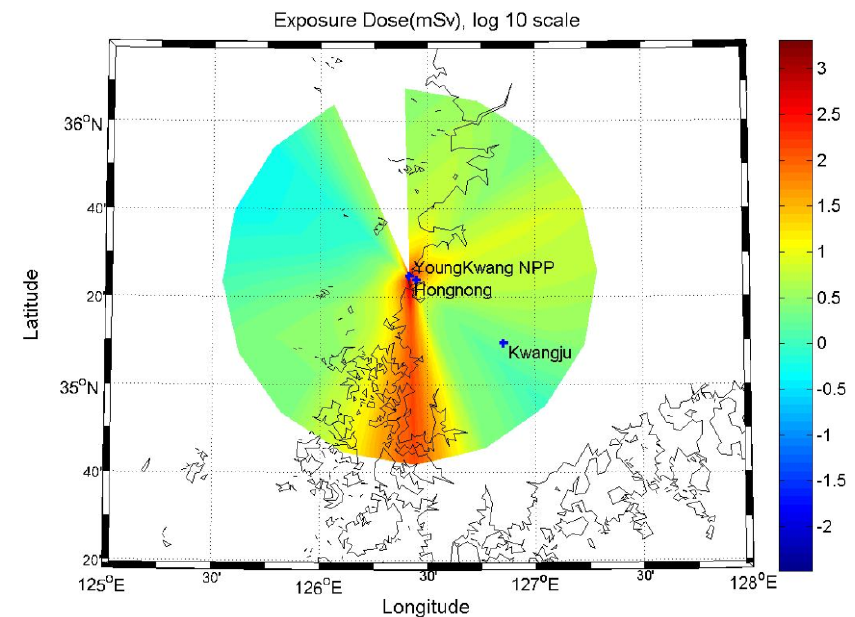
Figure 5. Hourly averaged effective radiation